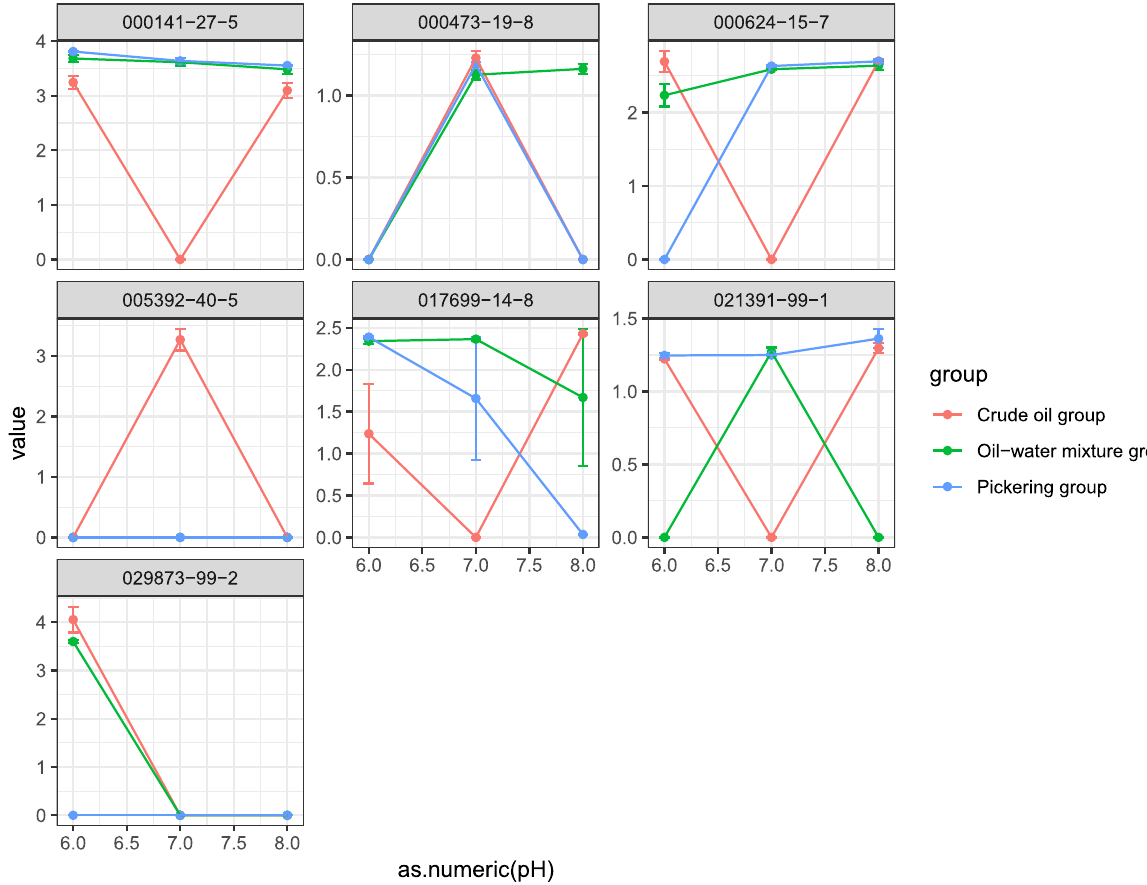
Fig. 6 Line graph of the difference components of each